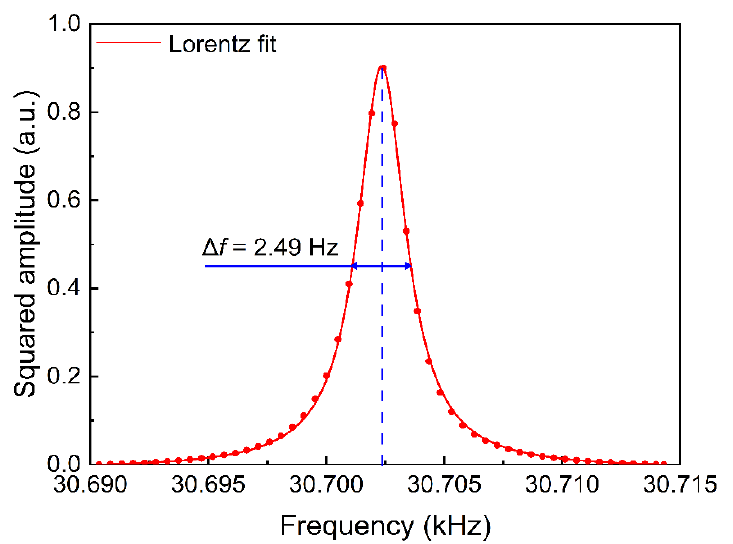
Figure 5. The frequency-response curve of the QTF. These data have been normalized and fitted by a Lorentz function.